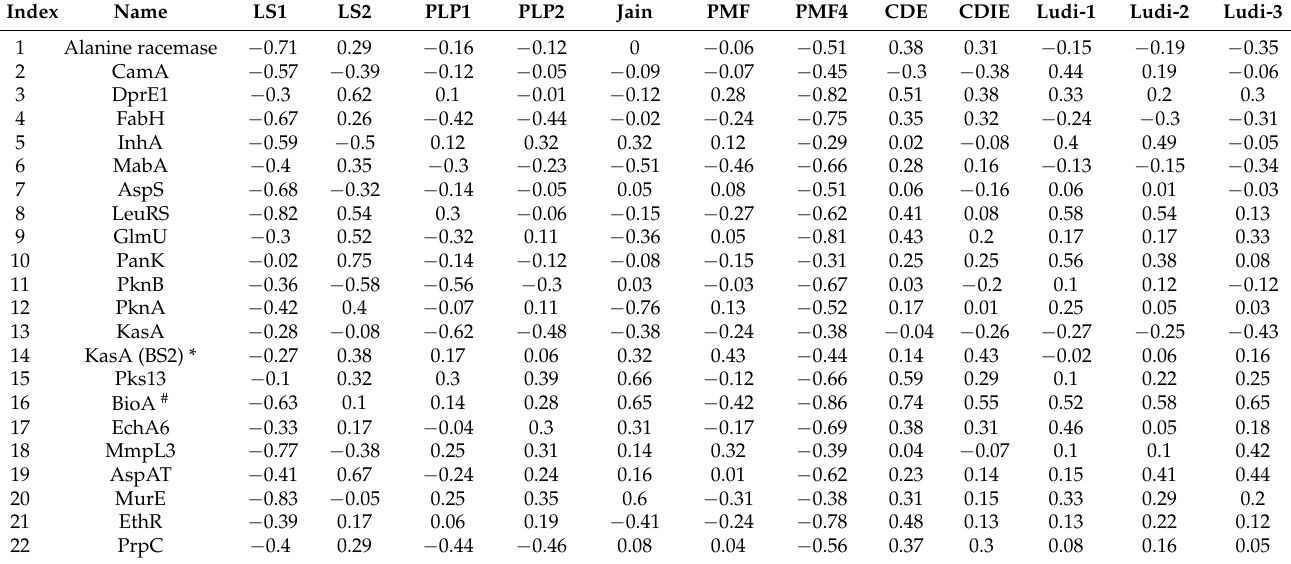
Table 2. The overall correlation coefficients matrix between the minimum inhibitory concentration values of the tested compounds and their computational scores obtained from different scoring functions for each of the selected target